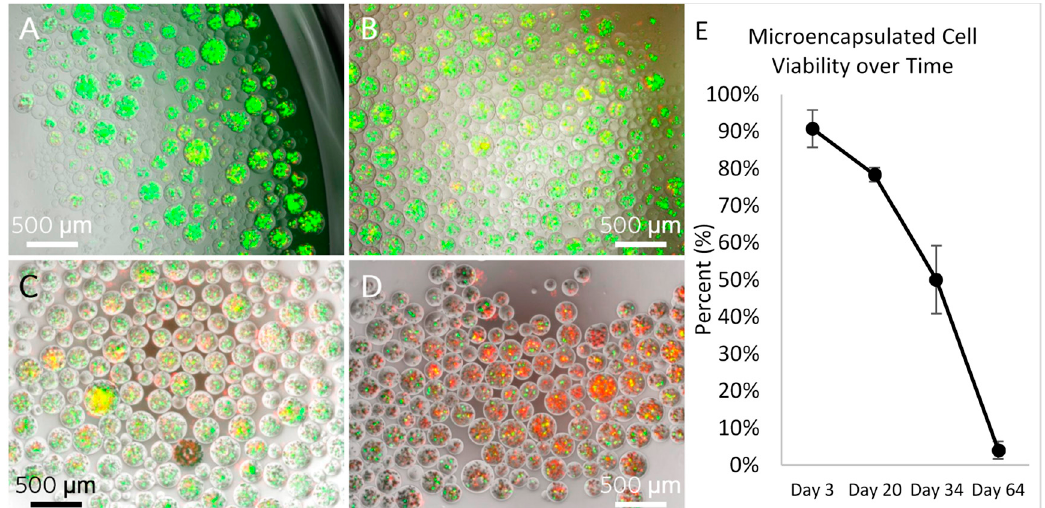
Figure 2. Calcium AM and ethidium homodimer-1 viability staining of microencapsulated hTERT-hMSCs over time. Green shows live and red shows dead. ( A ) Day 3, 90% ± 5% live cells. ( B ) Day 20, 78% ± 1% live cells. ( C ) Day 34, 50% ± 9% live cells. ( D ) Day 64, 4% ± 2% live cells. ( E ) Graph of viability over time.